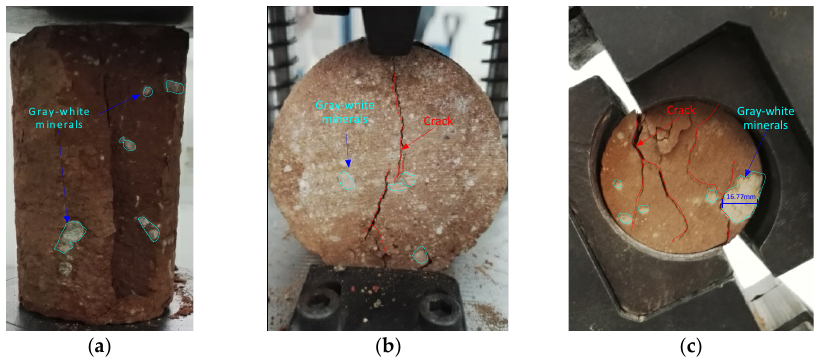
Figure 1. Rock foundation mechanical experiments: ( a ) compressive, ( b ) tensile, ( c ) shear.